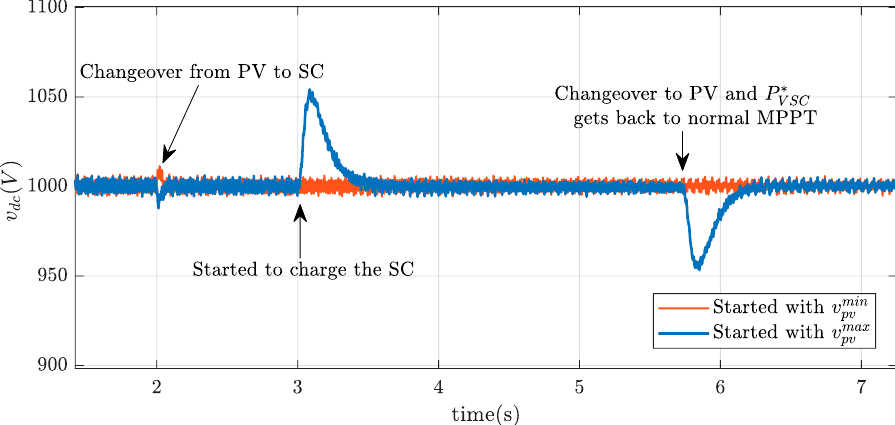
Figure 21. DC link voltage during changeover between PV and SC.